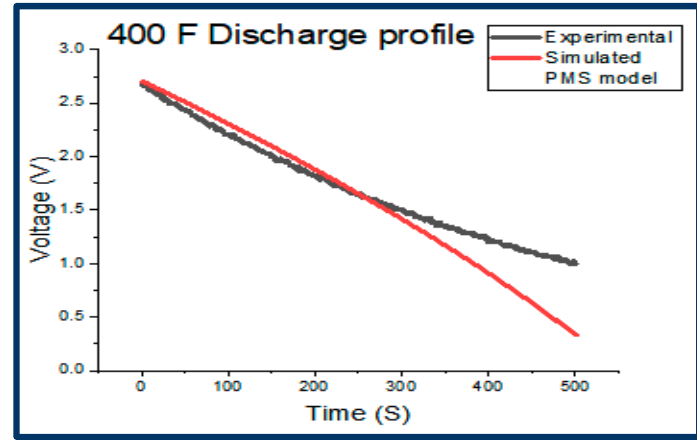
Figure 12. 400 F combined experimental/PMS-discharge profile.